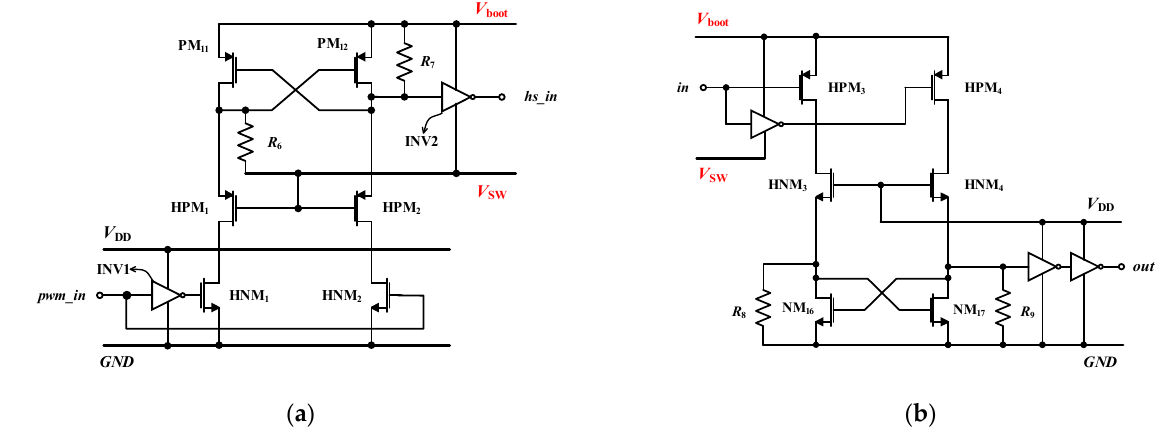
Figure 5. Circuit realization of ( a ) level-up shifter and ( b ) level-down shifter employed in proposed structure.